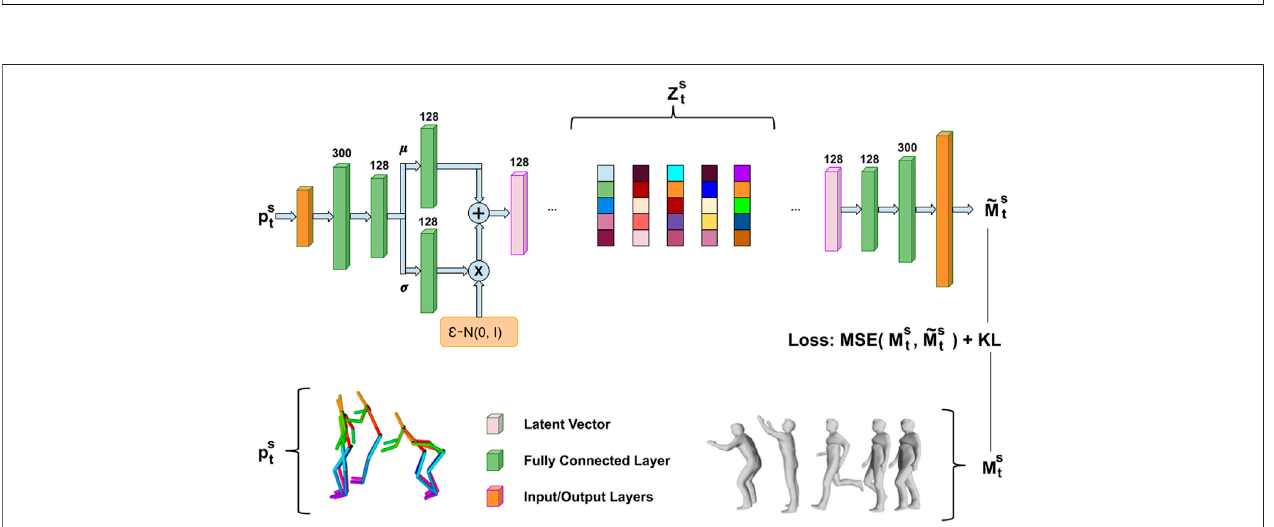
Frontiers in Virtual Reality |